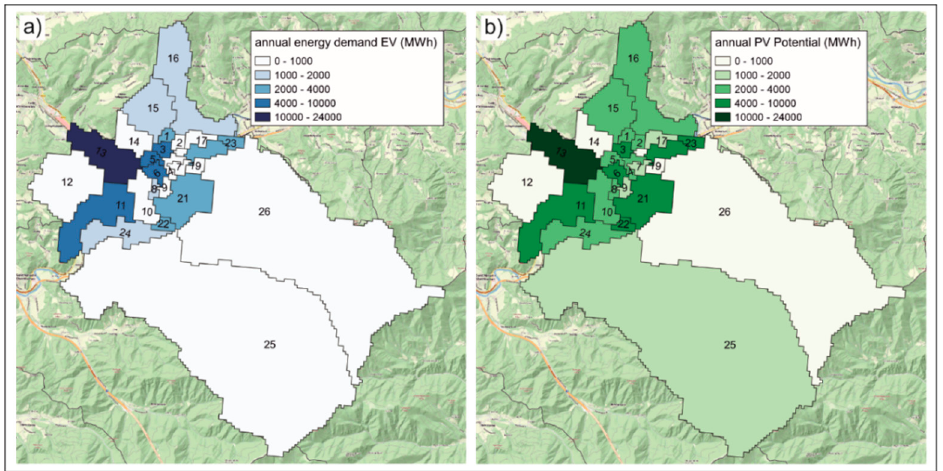
Figure 18. ( a ) Annual energy demand e-mobility and ( b ) annual PV potential at cell level for the city of Leoben. of